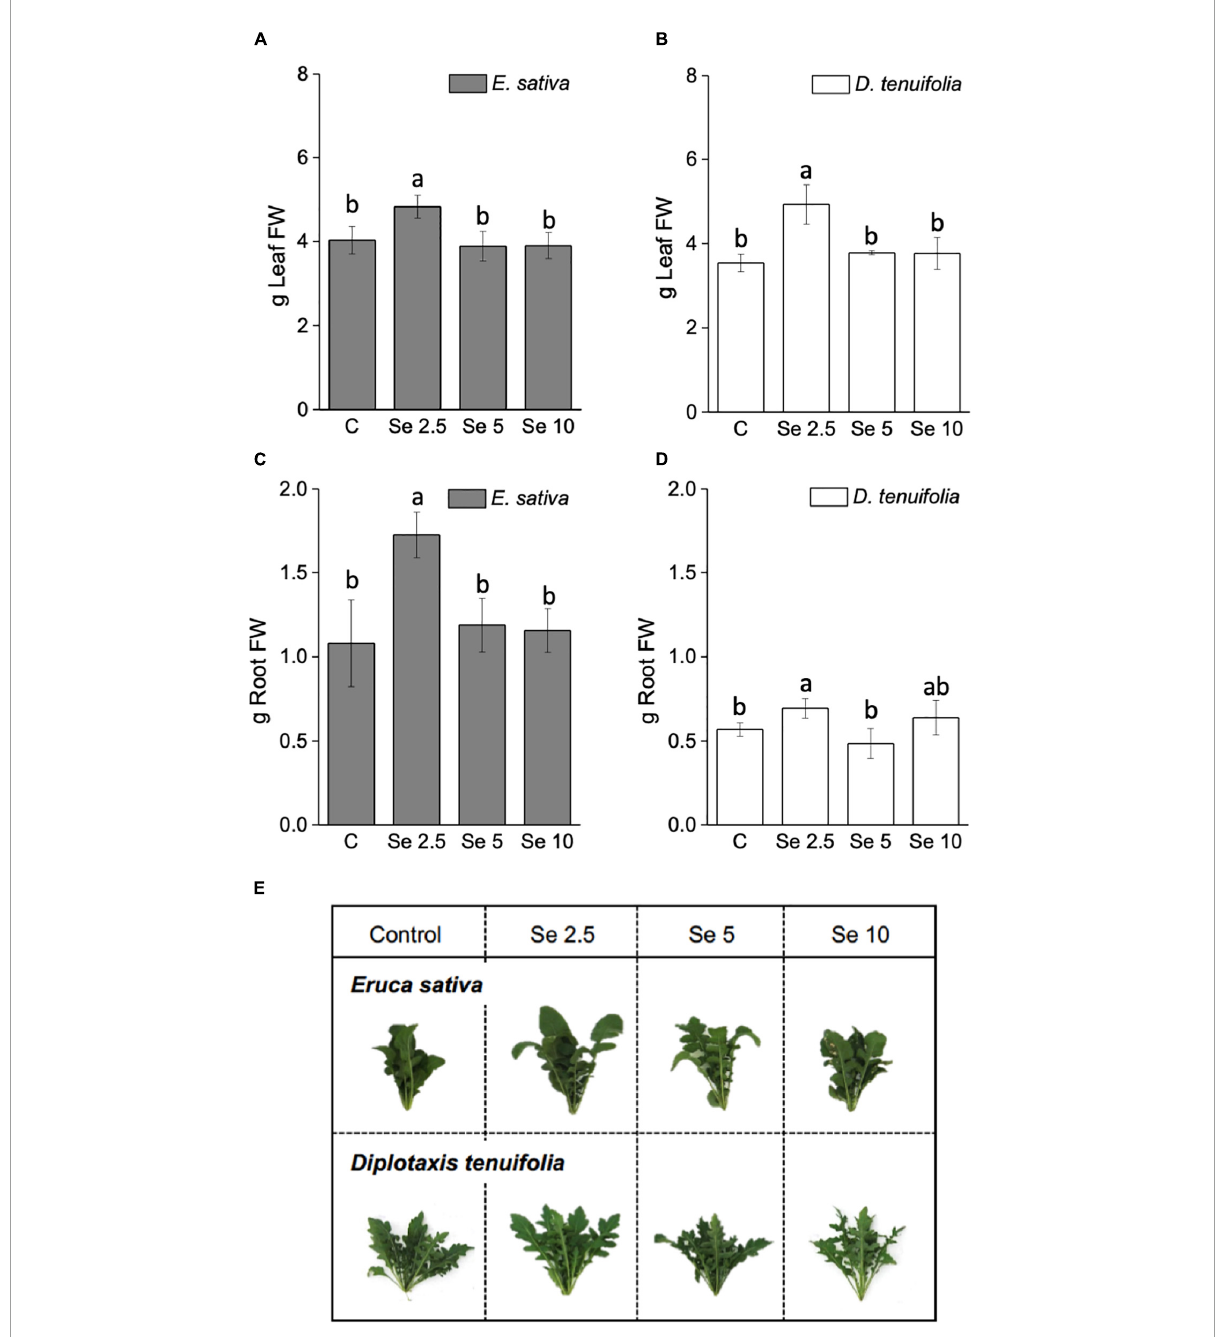
FIGURE1 Fresh weight (FW) of leaves (A,B) and roots (C,D) of E. sativa and D. tenuifolia plants grown in soil and subjected to foliar fertilization with selenate dosages ranging from 0 to 10 mg per plant. The FW reported is the average FW of each leaf ( ± SD, n = 6). Different letters above bars indicate significant differences between the means ( p < 0.05). (C,E) Images of representative rocket species fertilized with selenate.